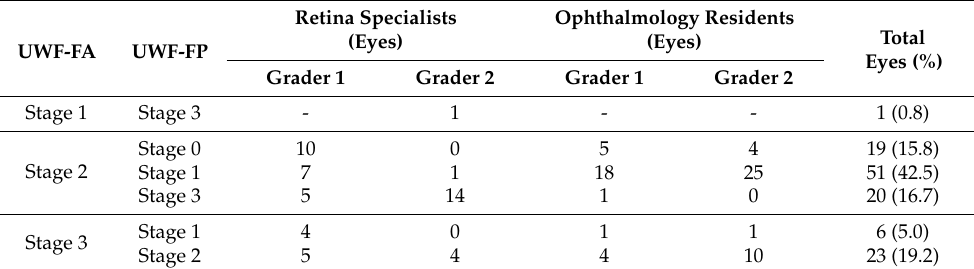
Table 3. Disagreements in Goldberg staging based on UWF-FP